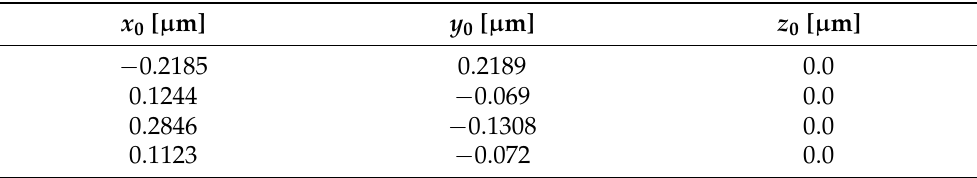
Table 2. Sample initial conditions for trapped trajectories, case-study with w 0 = 6.4 µ m.